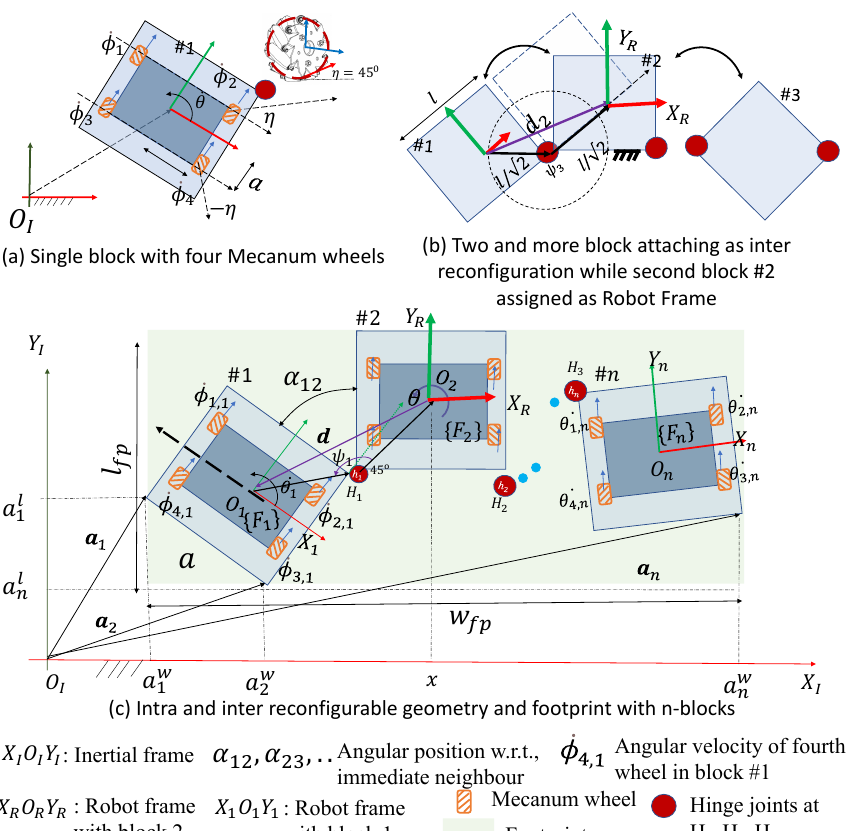
Figure 4. Block diagram of Smorphi with the labeled relative angles between consecutive blocks as α 12 between B1 and B2. The footprint dimensions denoted as l fp and w fp